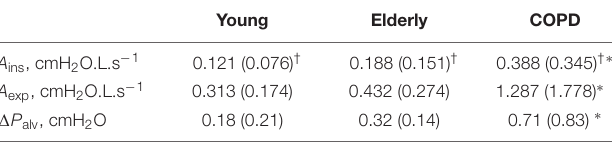
TABLE 3 | Loop-derived parameters in healthy and COPD subjects.